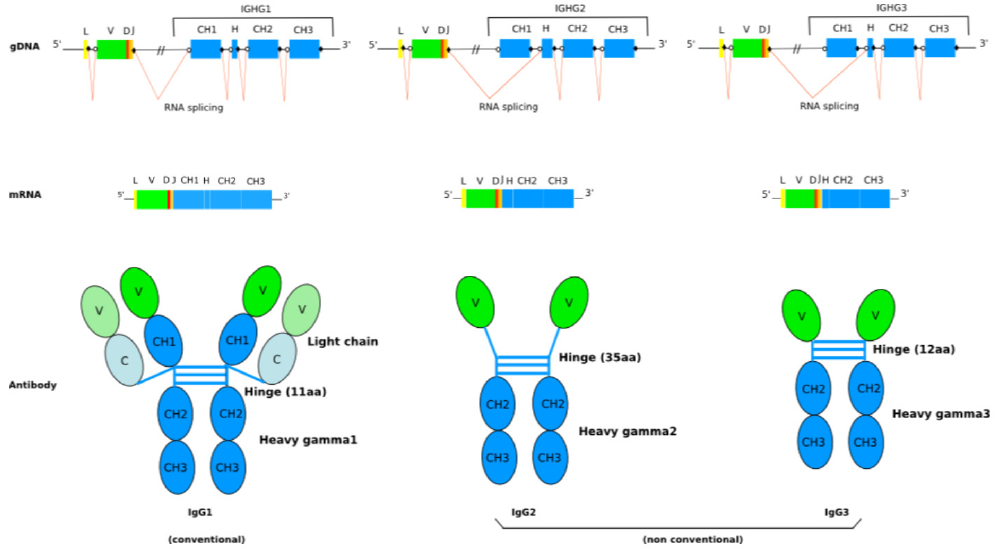
Figure 33. Characteristics of the immunoglobulin synthesis in Camelidae. The Arabian camel ( Camelus dromedarius ) and the llama ( Lama glama ) have three IgG subclasses: the conventional IgG1 and